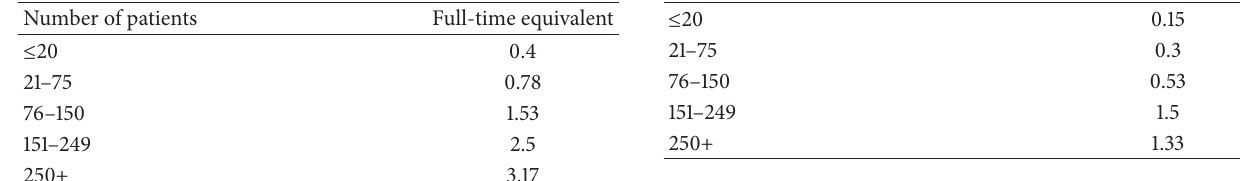
Table 2: Nurse coordinator/clinic coordinator.